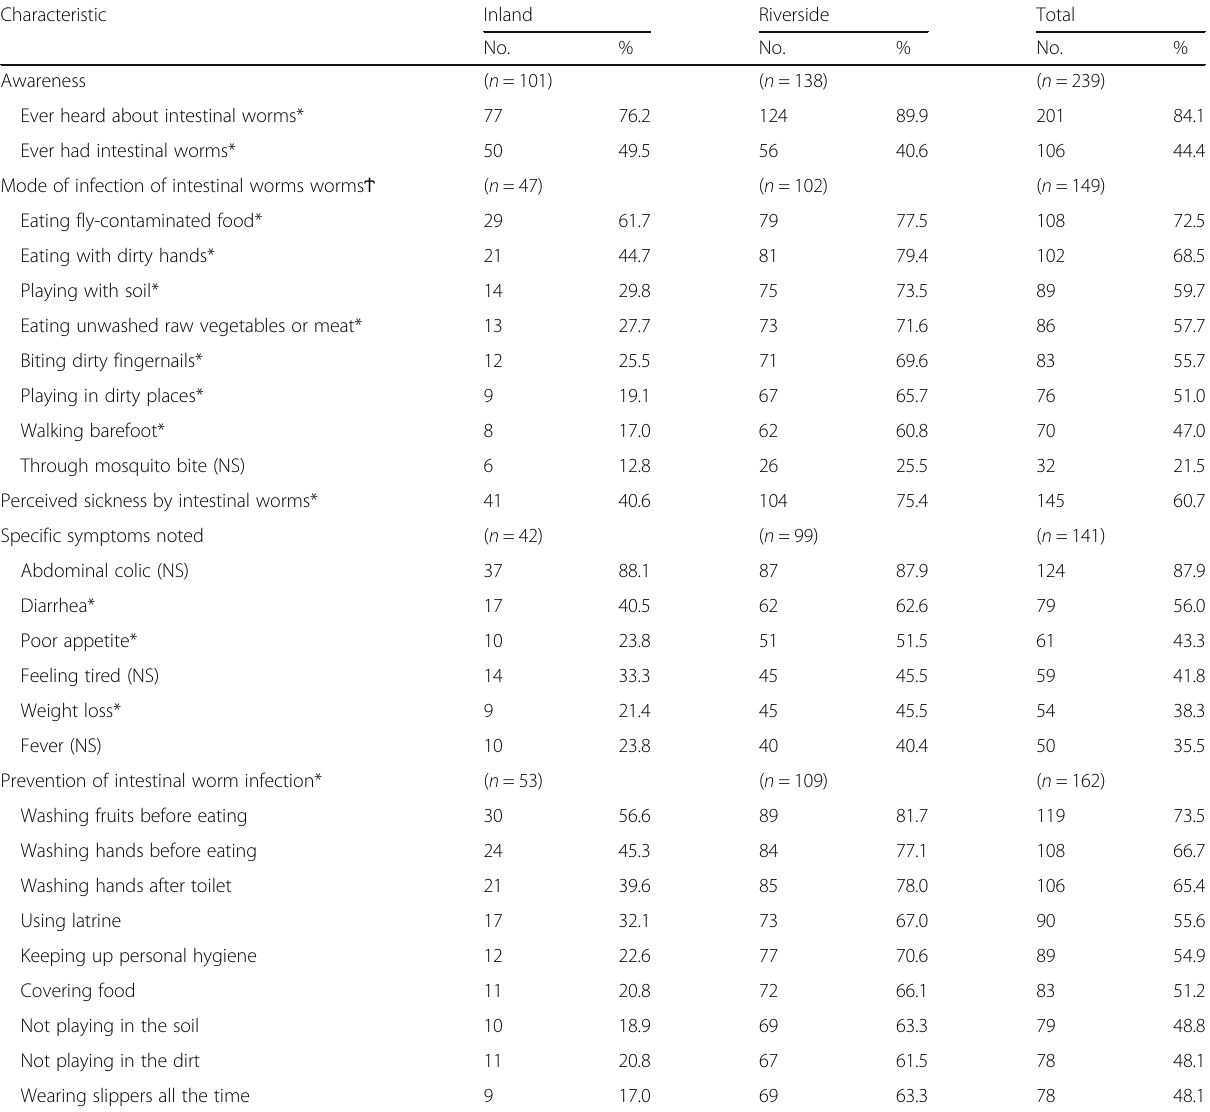
Table 4 Knowledge of intestinal worms by study site, Shwegyin Township, Myanmar, 2017 Characteristic Inland